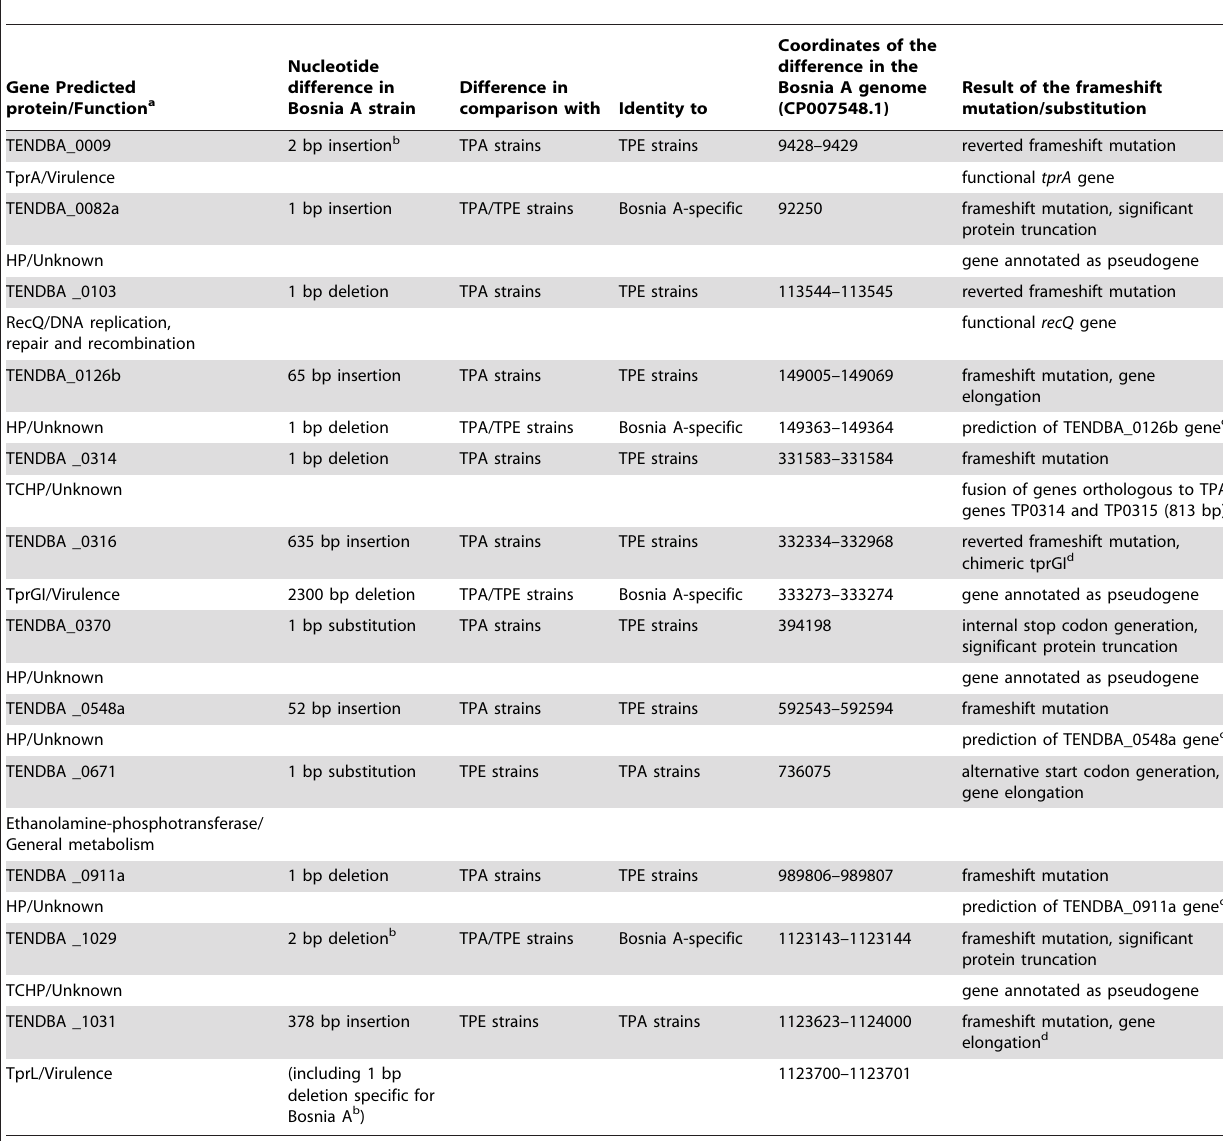
Table 2. Frameshift mutations and substitutions resulting in significant protein truncations, elongations and novel annotations in the Bosnia A genome in comparison with TPA and TPE strains.